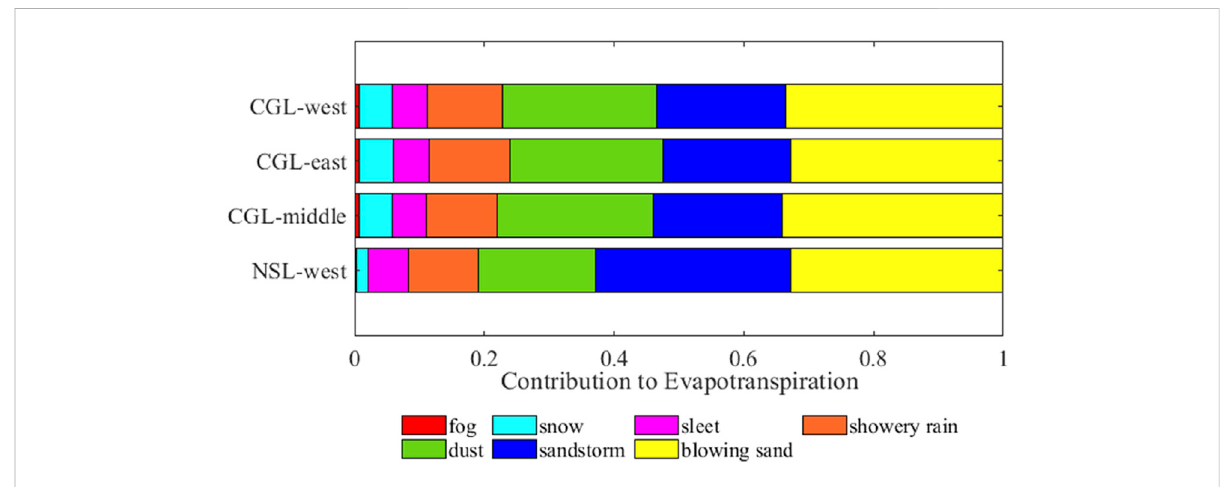
FIGURE 5 Contribution rates of different weather conditions to